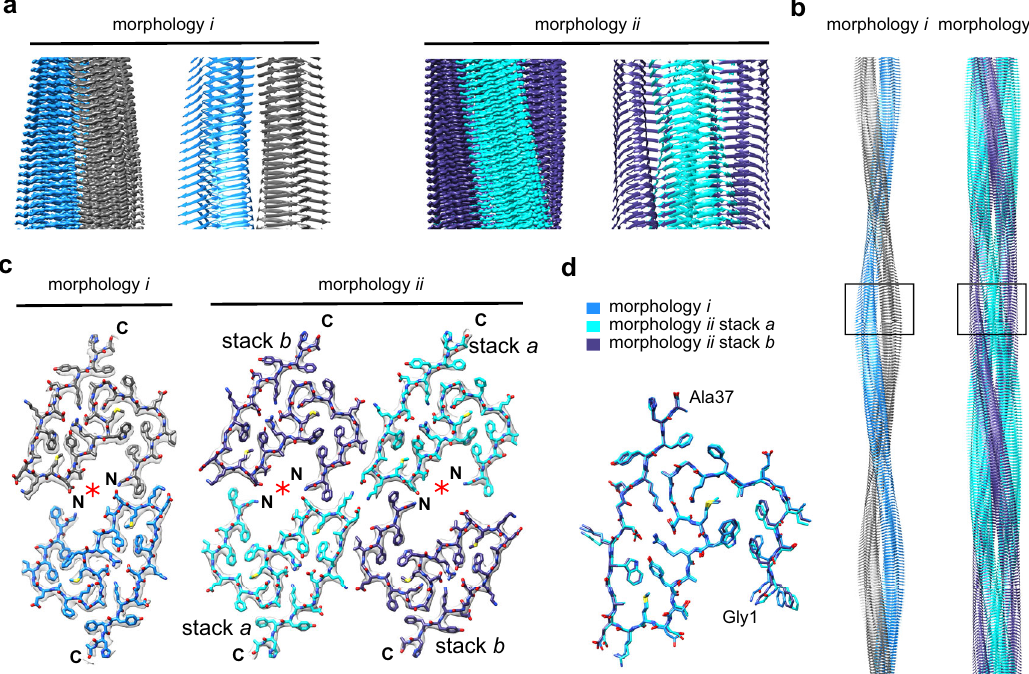
Fig. 2 Cryo-EM structures of amyloid fi brils from recombinant SAA1.1 protein in vitro. a Side views of fi bril morphologies i and ii: corresponding sections of the 3D maps and models, shown as ribbon diagrams. b Models of fi brils in side view. The segment shown in a is boxed. c Cross-sectional layers of fi bril morphologies i and ii. The 3D maps (gray surfaces) are superimposed with the models, shown as sticks. Red asterisk: cavity of the structure. d Alignment of the fi bril proteins of morphology i and ii (stacks a and b ) as indicated in the fi